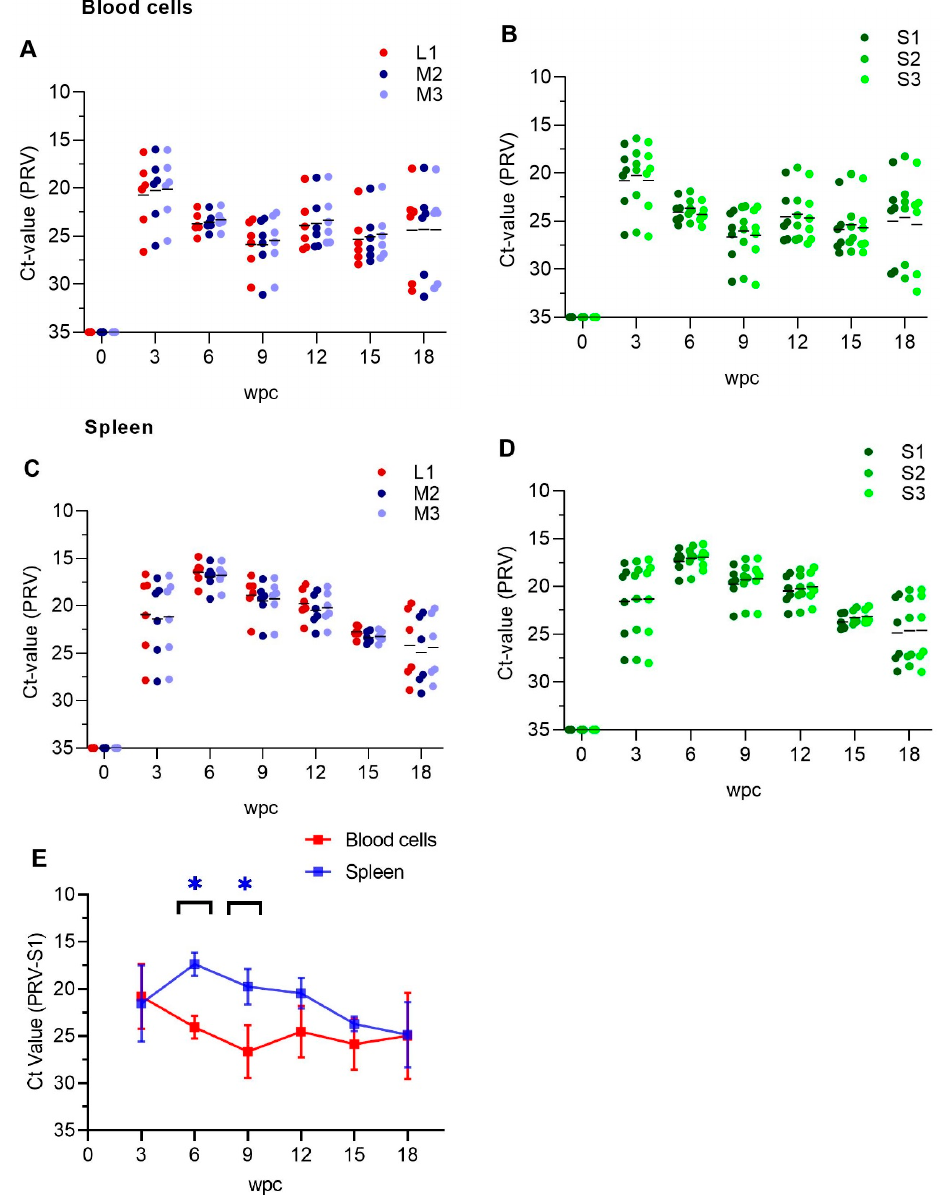
Figure 1. Expression analysis of PRV-1 segments and transcripts. qPCR detection of segment L1, M2, M3, S1-S3 and corresponding transcripts in blood cells ( A , B ) and spleen ( C , D ) from Atlantic salmon. Individual fish shown as dots, and mean Ct value-PRV as lines. n = 6 for each point. ( E ) S1 as a representative for PRV genomic segments expression between blood cells and spleen. Paired analysis was performed by non-parametric Wilcoxon matched pairs signed rank test ( p < 0.05), asterisk (*) indicates significantly di ff erent group. wpc = weeks post